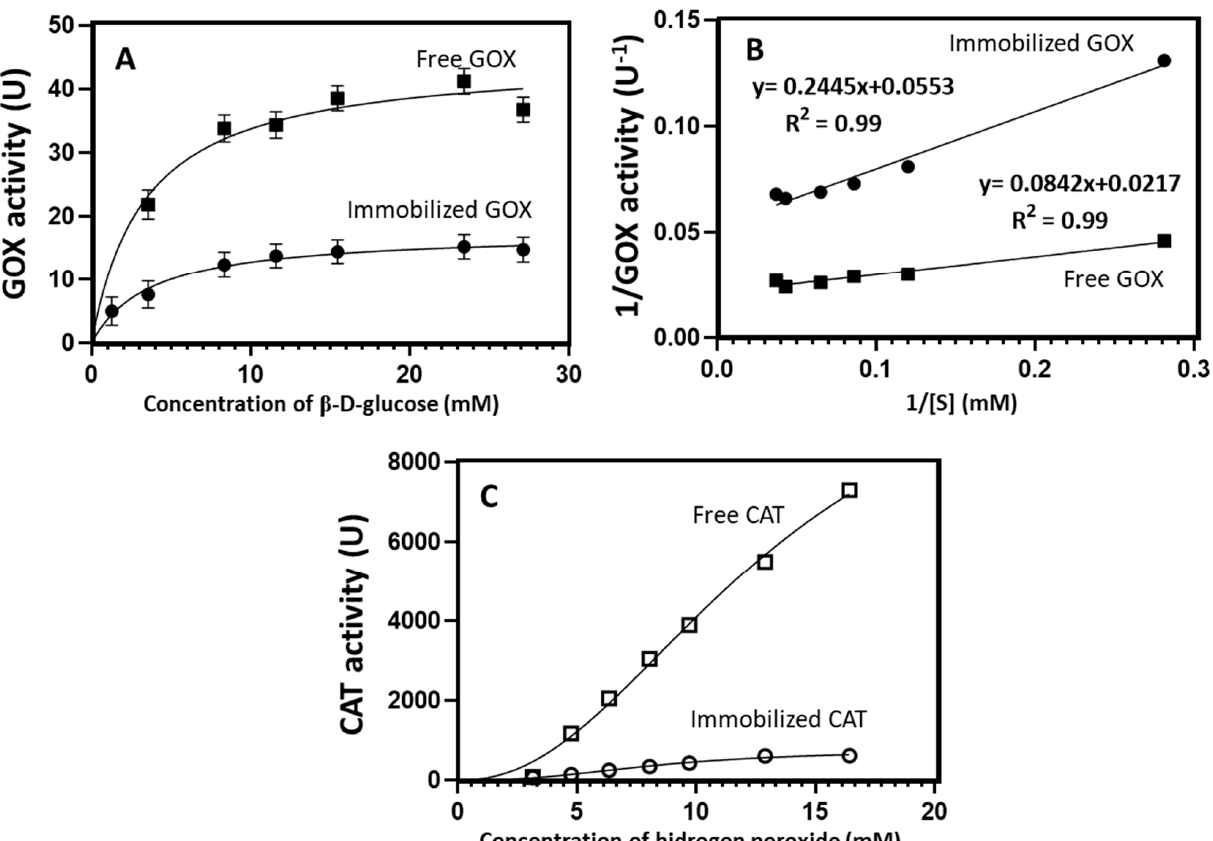
Figure 4. Michaelis–Menten curve ( A ) and Lineweaver–Burk plot ( B ) for the determination of kinetic parameters of free and immobilized GOX. Velocity curve as a function of the substrate ( C ) showing the allosteric sigmoidal behavior of free and immobilized CAT.